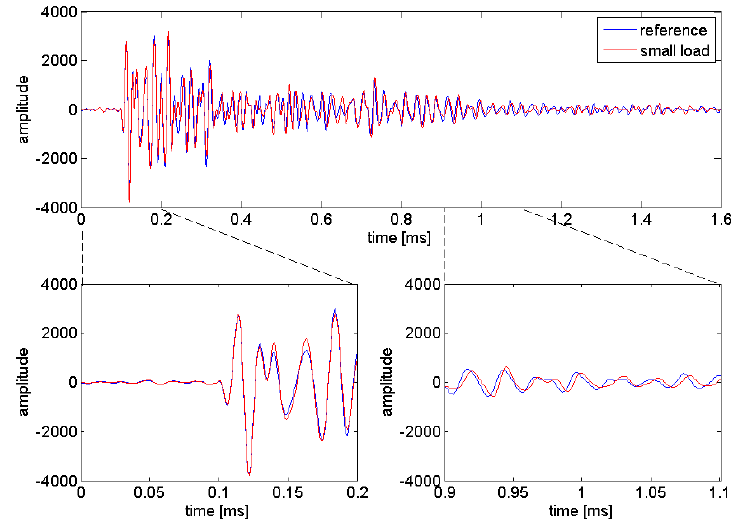
Figure 2. Ultrasonic signals (All ultrasonic signals in Section 2 are acceleration data in arbitrary units, as recorded by the data acquisition system. The real (absolute) values are not important for the issues discussed here) for the same configuration and sample, without load (reference) and subjected to a small load. While time of flight almost remains constant, the late part of the signal (coda) shows a significant phase change. Experimental data from the load test is described later.